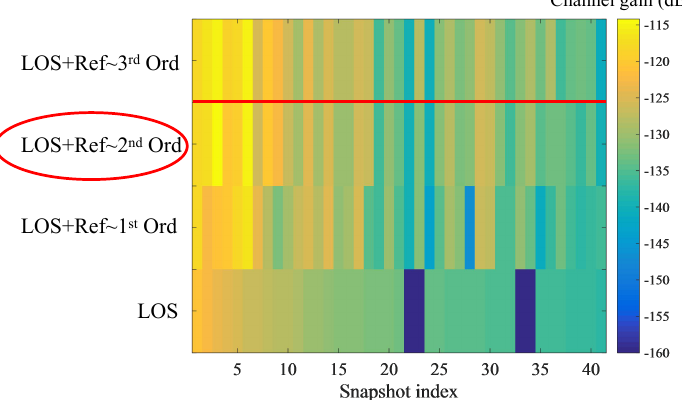
Figure 6. Reconstructed bus and receiver (Rx) location.